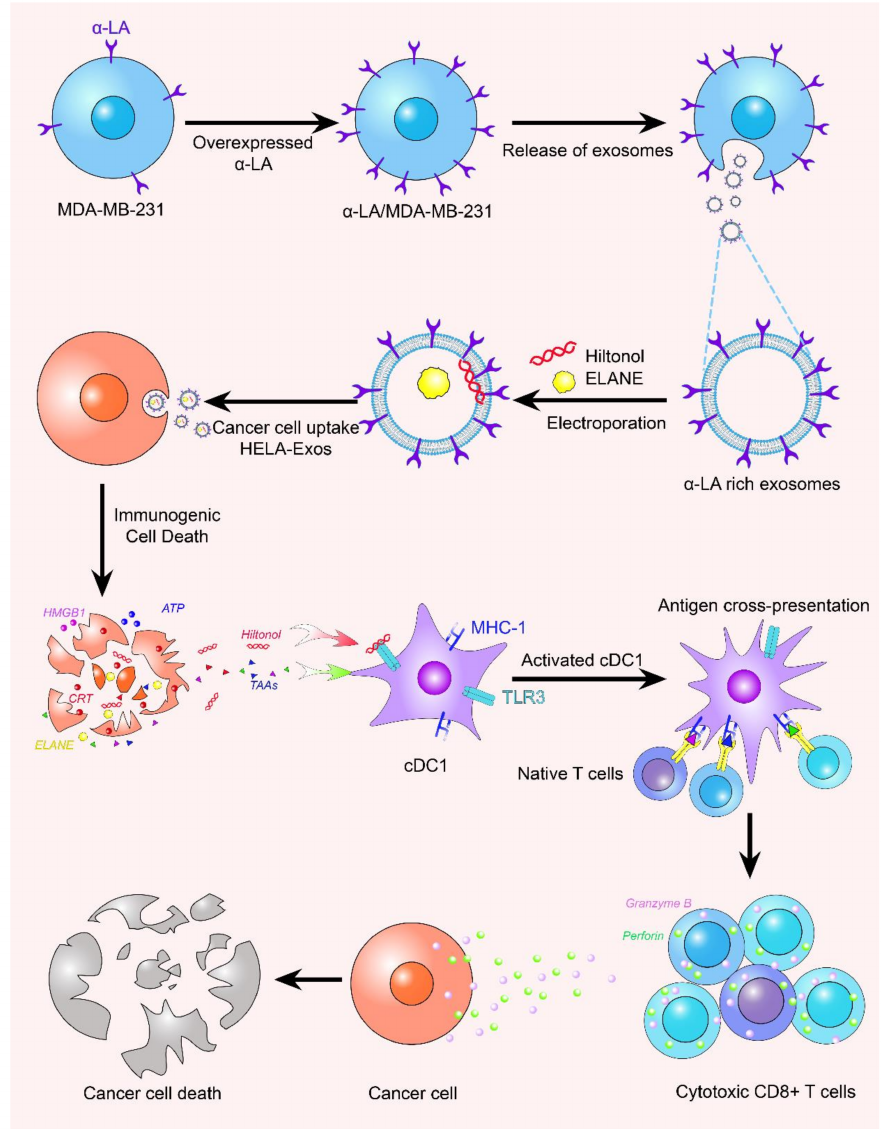
Figure 3. The expression of α -lactalbumin was low in breast cancer cell line MDA- MB-231. After overexpression treatment, the exosomes released by it had the characteristics of α -lactalbumin overexpression. Through electroporation, ELANE and hiltonol are mixed into the interior, and the uptake of cancer cells induces ICD. Subsequently, various substances released activate cDC1s, causing the activation of CD8 + T cells, and then killing cancer